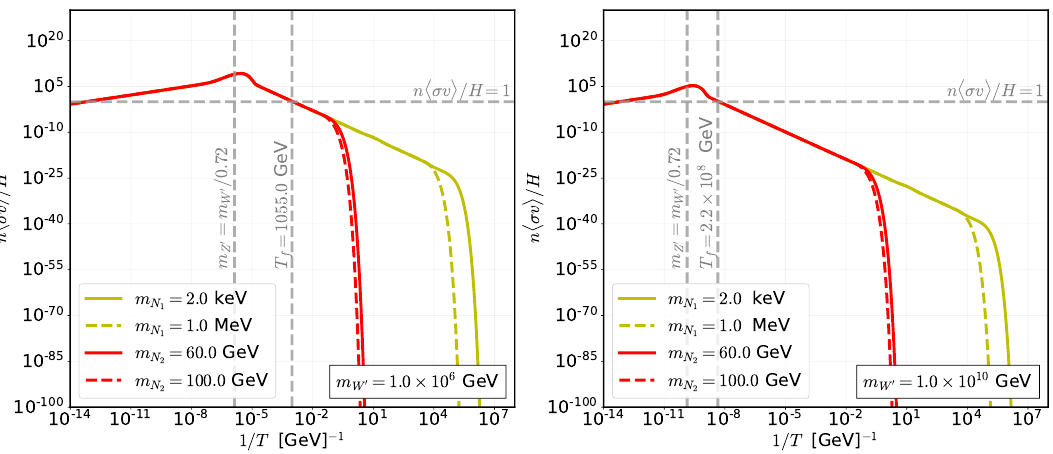
Figure 2 . Ratio between the interaction rates Γ ≡ n h σv i and the Hubble rate H for N 1 (yellow) and N 2 (red) annihilations as a function of the inverse of temperature. The left panel accounts for m W 0 = 1 . 0 × 10 6 GeV and the right panel, for m W 0 = 1 . 0 × 10 10 GeV. The dashed horizontal line represents Γ /H = 1 , below which the sterile neutrinos are decoupled. The dashed vertical lines indicates where T = m Z 0 and T = T f